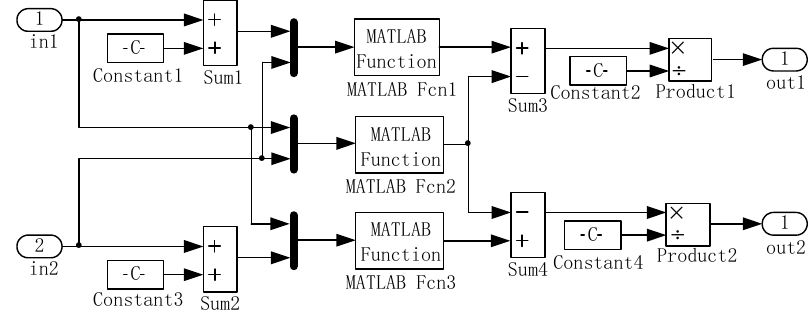
Figure 10. Expanded “ Subsystem ” module.